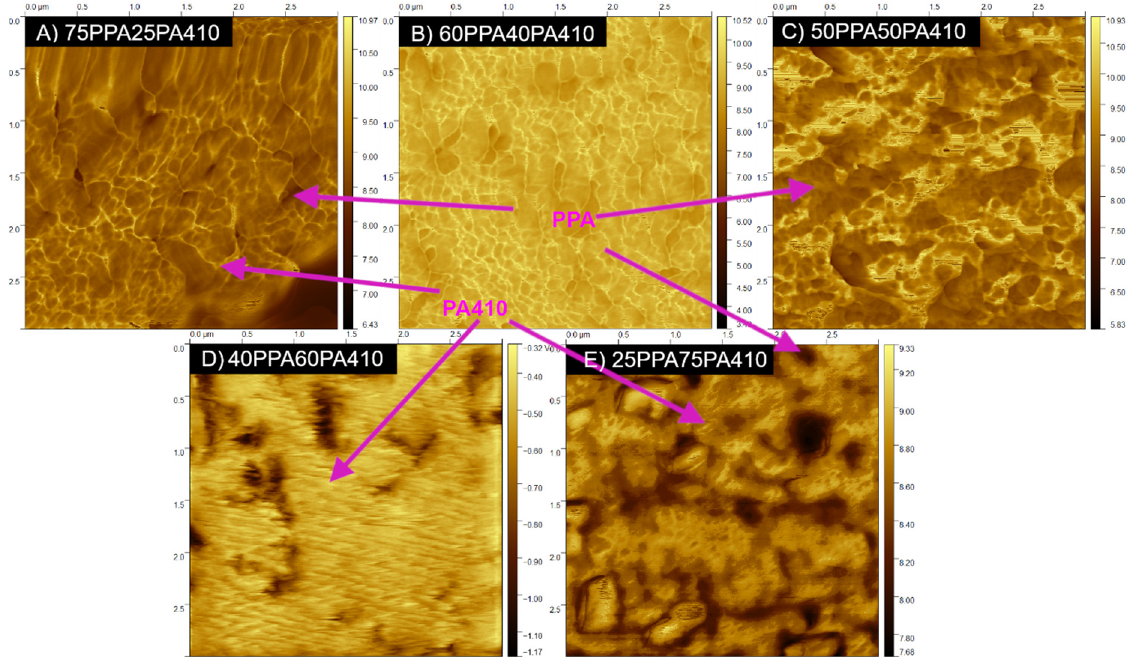
Figure 5. AFM modulus images of all the PPA/PA410 blends: ( A ) 75PPA25PA410; ( B ) 60PPA75PA410; ( C ) 50PPA50PA410; ( D ) 40PPA60PA410; ( E ) 25PPA75PA410. The dimensions of all squares are 3 μ m × 3 μ m.